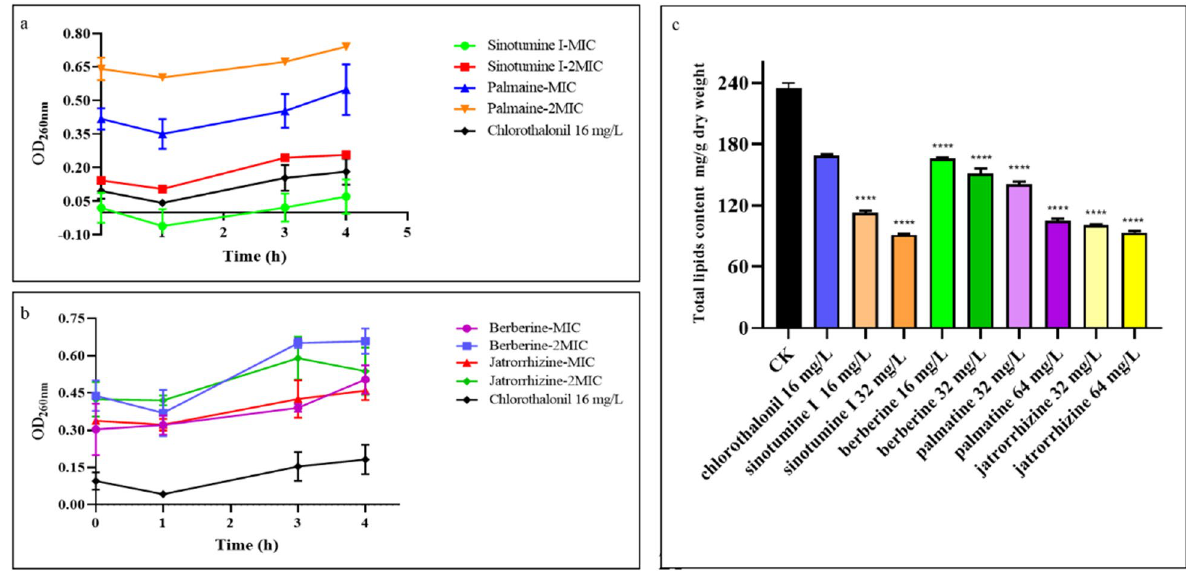
Fig. 4 Effects of compounds at MIC and 2 MIC on the release of 260 nm absorption substances of B. cinerea treated with sinotumine I and palmatine ( a ); berberine and jatrorrhizine ( b ); total lipid content of B. cinerea cells in the presence of different concentrations of the compounds sinotumine I, palmatine, berberine and jatrorrhizine ( c ). Data displayed were the average value of the aggregated data. ****P < 0.0001 versus